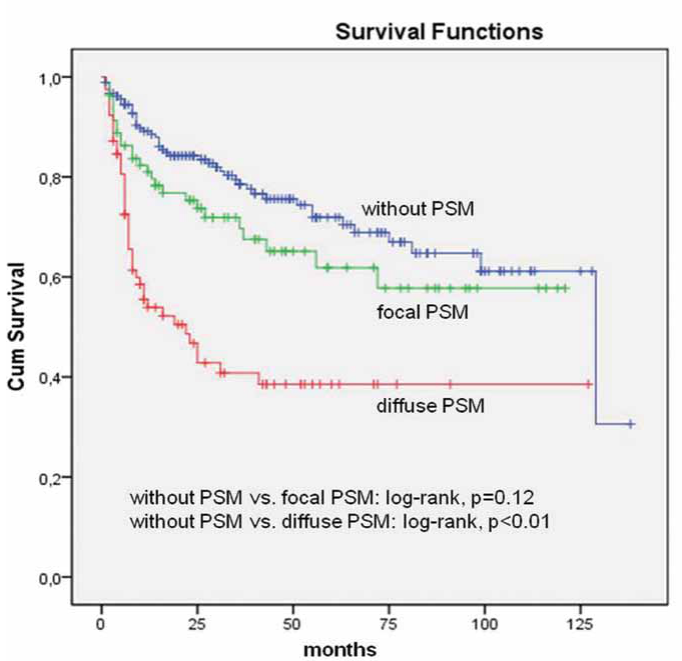
Figure 3 - Kaplan-Meier biochemical (PSA) progression-free survival curve comparing 183 surgical specimens without PSM vs 81 surgical specimens with focal PSM (Group 1), and 78 surgical specimens with diffuse PSM (Group